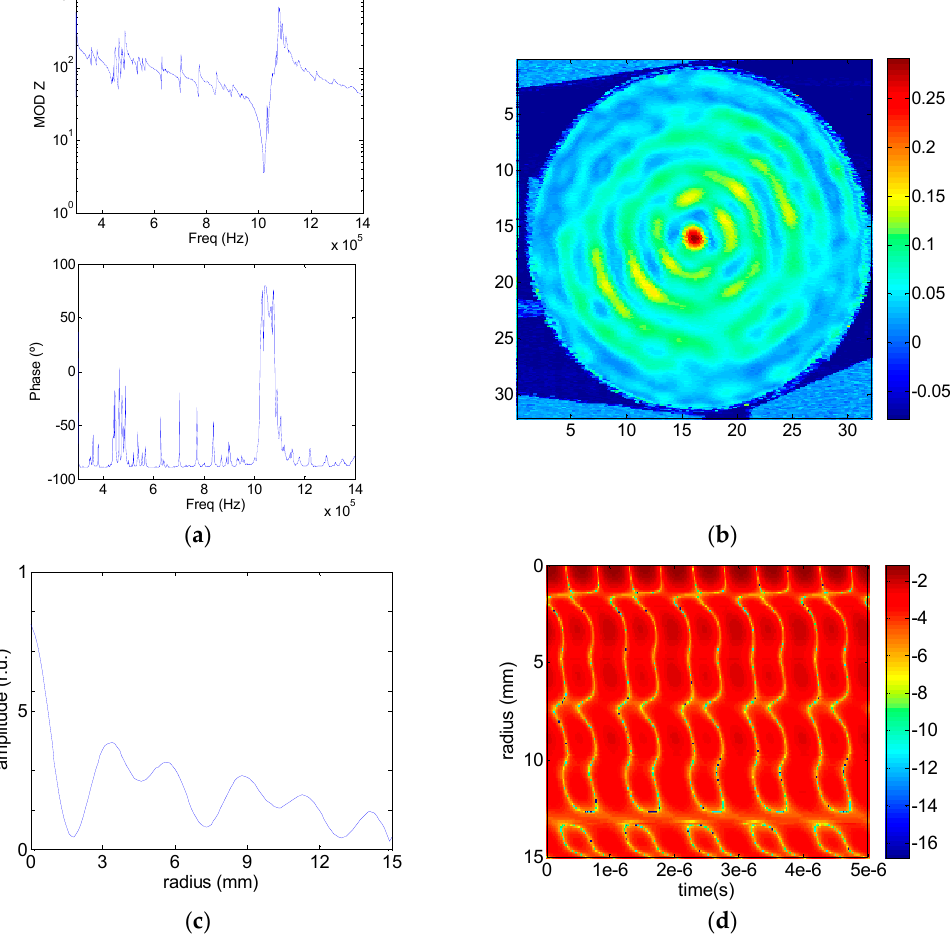
Figure 9. Experimental results with Model 1, ( a ) Module and phase of the electrical impedance; ( b ) Aluminum surface out-of-plane mechanical displacement in linear arbitrary units; ( c ) Mechanical displacement amplitude along the radius; ( d ) Relative mechanical displacement amplitude as a function of time along the radius in logarithmic scale.